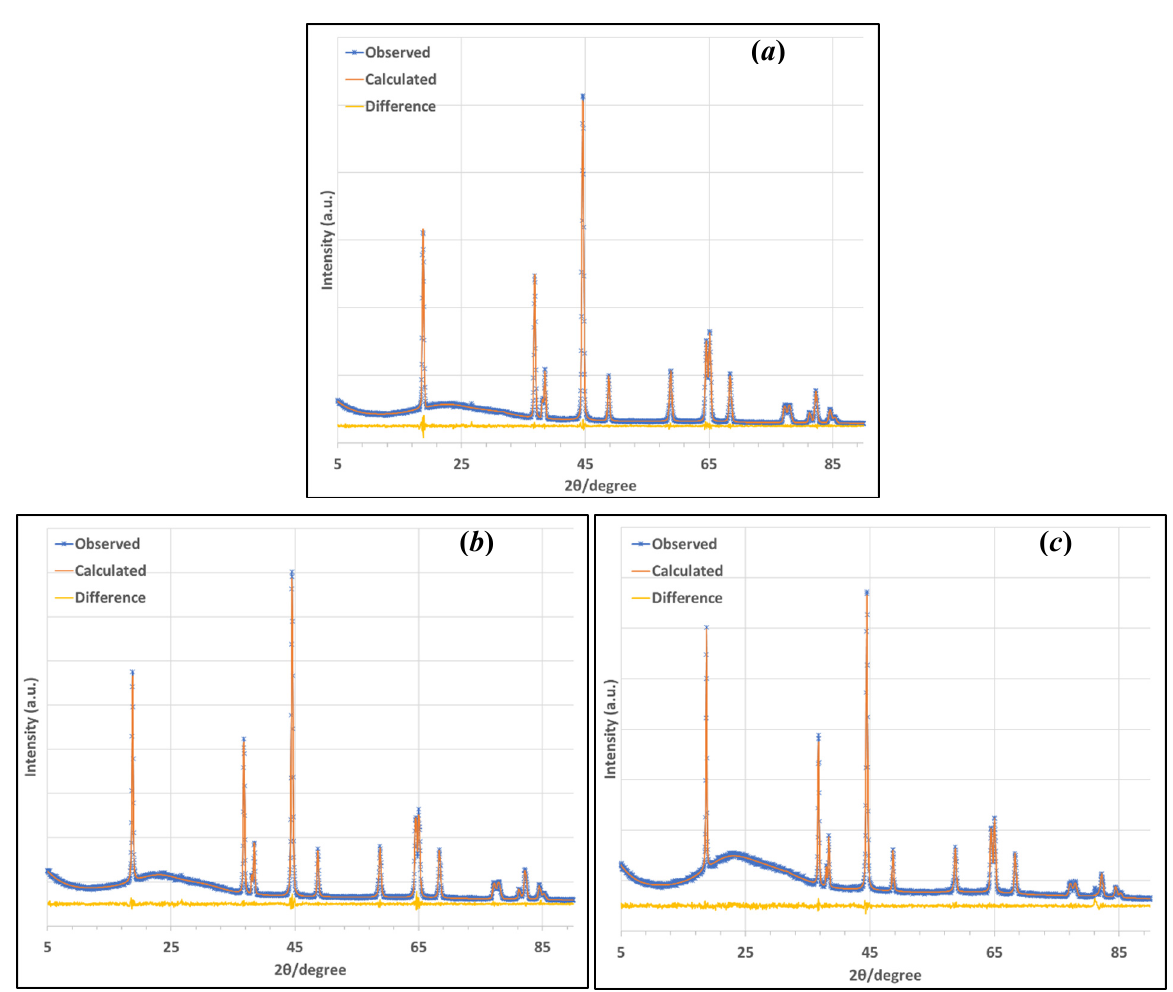
Figure 8. XRD analysis of ( a ) uncoated NMC-60, ( b ) 1% LNO coated NMC-60 using Method-I, and ( c ) 1% LNO coated NMC-60 using Method-II.